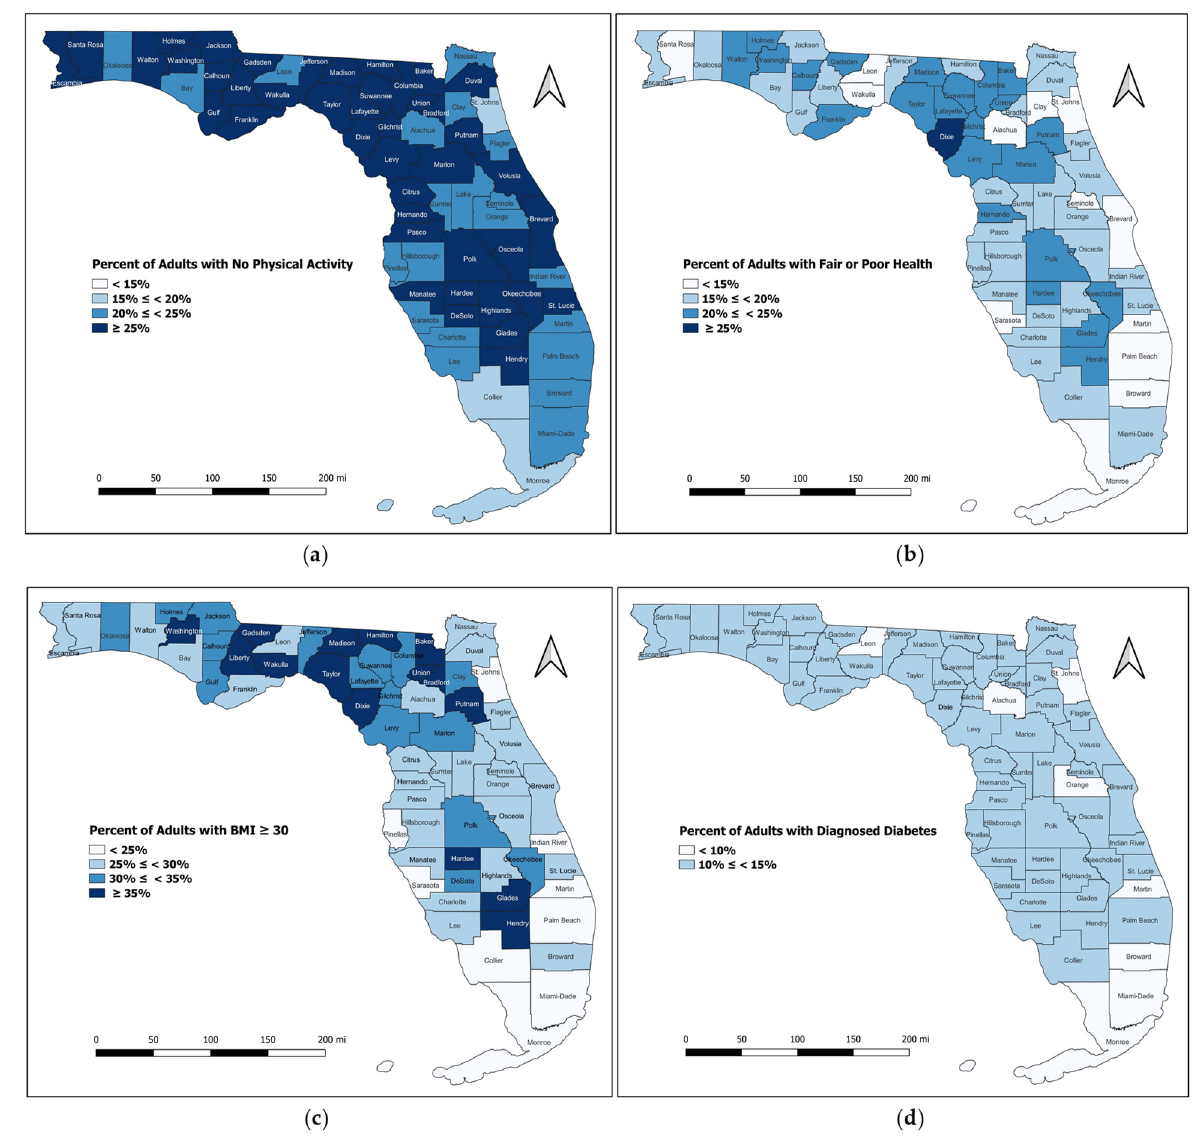
Figure 4. Prevalence of physical inactivity and health conditions by Florida county: ( a ) prevalence of physical inactivity; ( b ) prevalence of poor or fair health; ( c ) prevalence of obesity; ( d ) prevalence of diabetes.